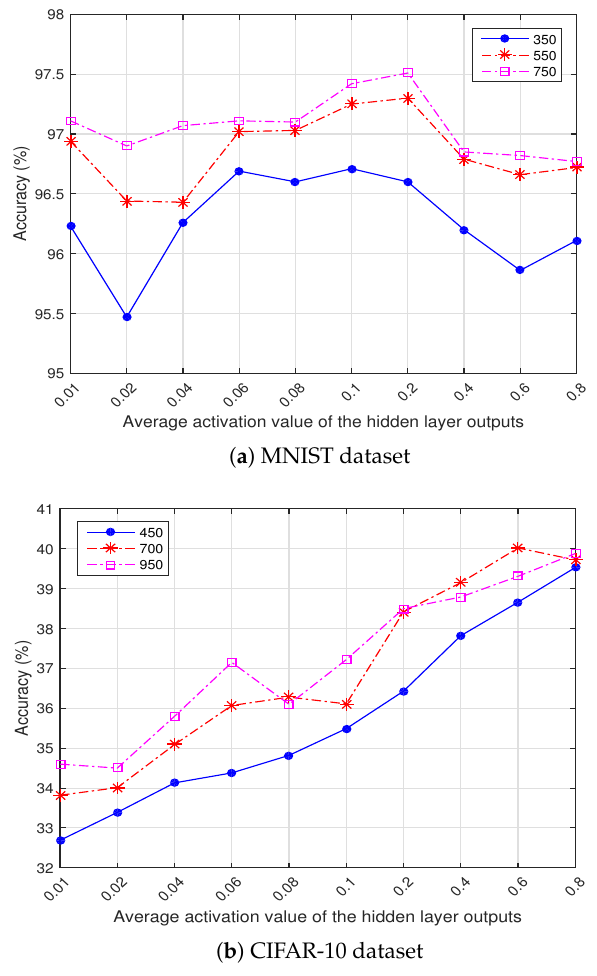
Figure 2. The relationship between the average activation value of the hidden layer outputs and classification performance in the REAN autoencoder